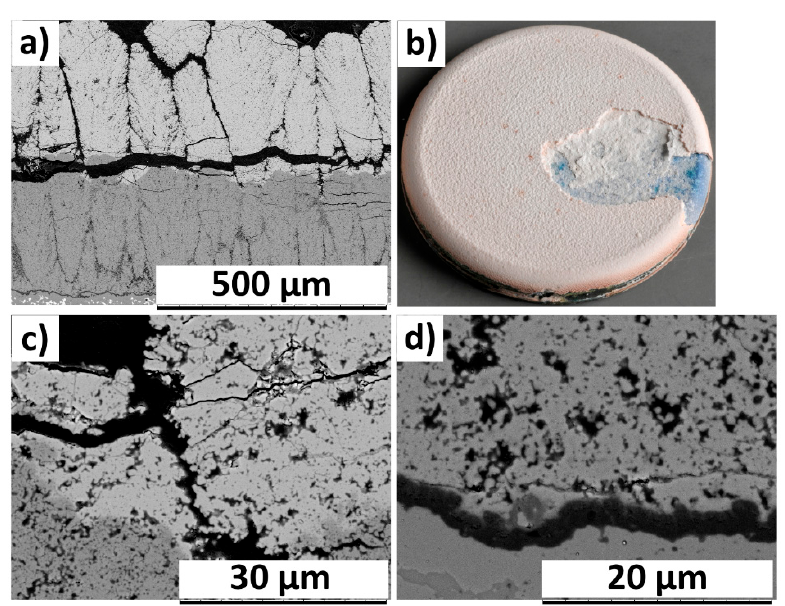
Figure 9. SEM micrograph of BRT failed (301 cycles) 250GZ / 250YSZ ( a ) Cross section; ( b ) photograph; ( c ) high magnification cross sectional view; ( d ) TGO.